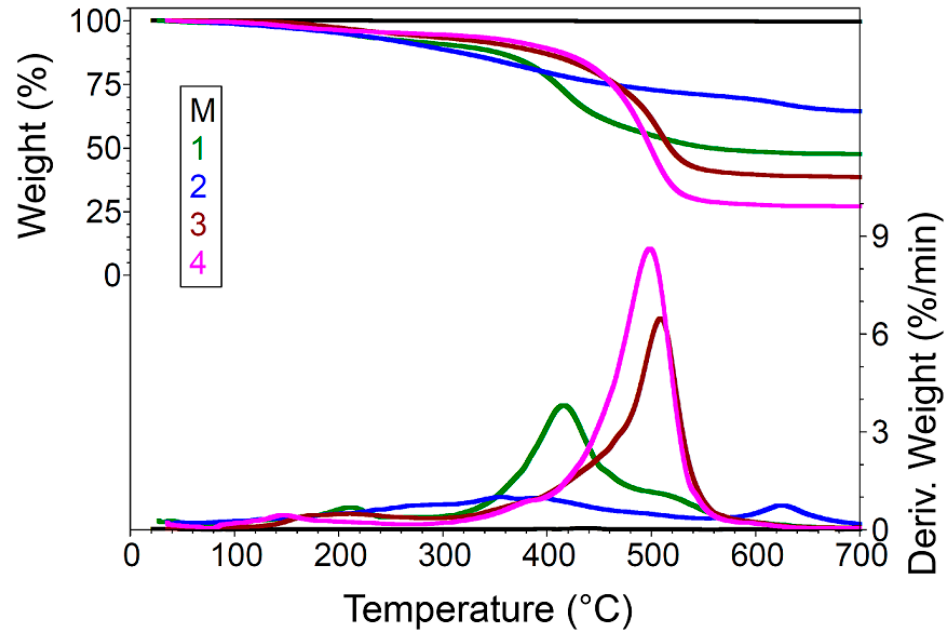
Figure 5. TGA curves of unfunctionalized ZnO (M) and of dried ZnO materials modified with (1) GPTMS, (2) PhTES, (3) OTES, and (4) ODTES,; respectively.